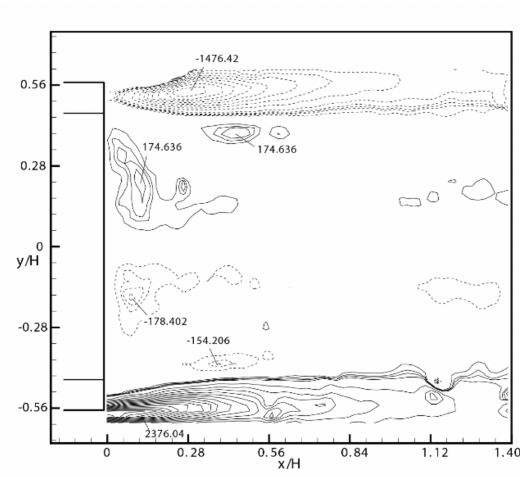
Figure 27. Iso-contours of averaged streamwise vorticity, ω z in x–y plane at z/H = − 0.19. Minimum and incremental values of vorticity are ω z,min = − 100.539 s − 1 , 98.948 s − 1 , and ∆ ω z = 117.932 s − 1 , respectively.